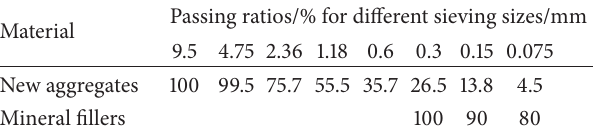
Table 2: Gradations for new aggregates and mineral fillers.